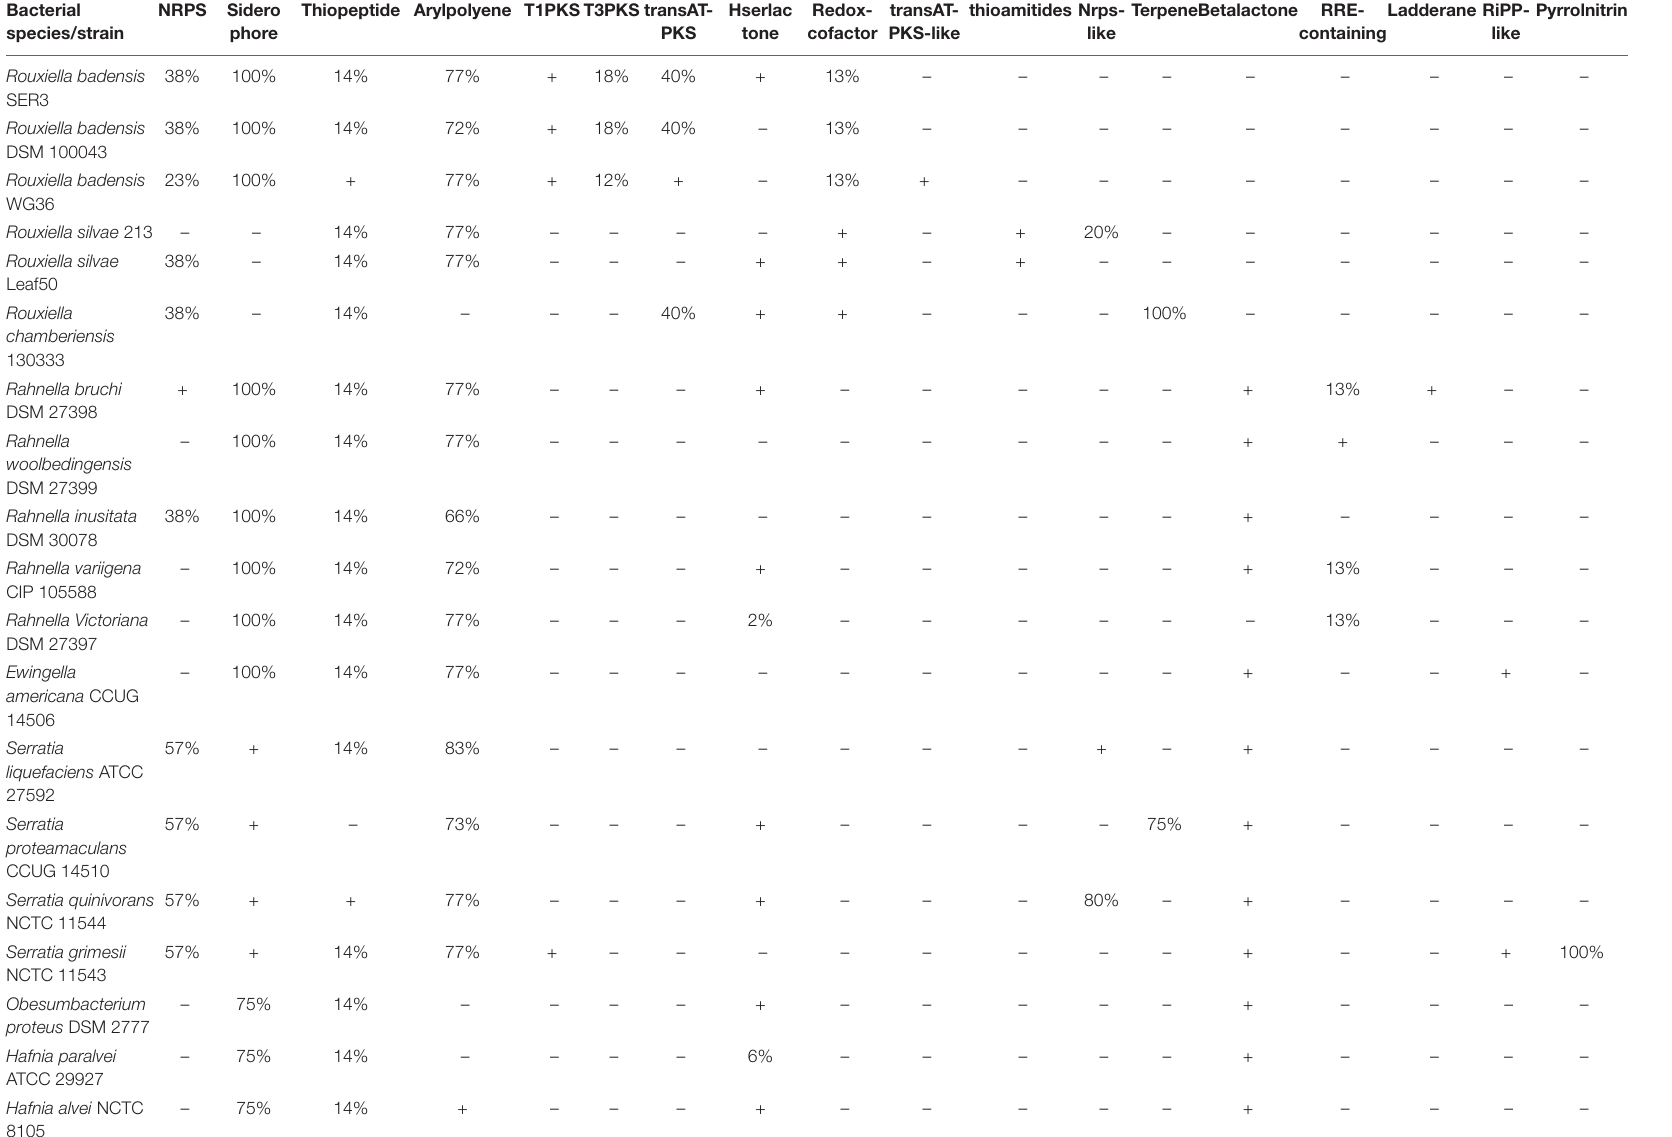
TABLE 4 | AntiSMASH analysis and prediction of biosynthetic compounds in R. badensis SER3 and related bacterial genomes. Bacterial NRPS Sidero Thiopeptide Arylpolyene T1PKST3PKS transAT- species/strain phore